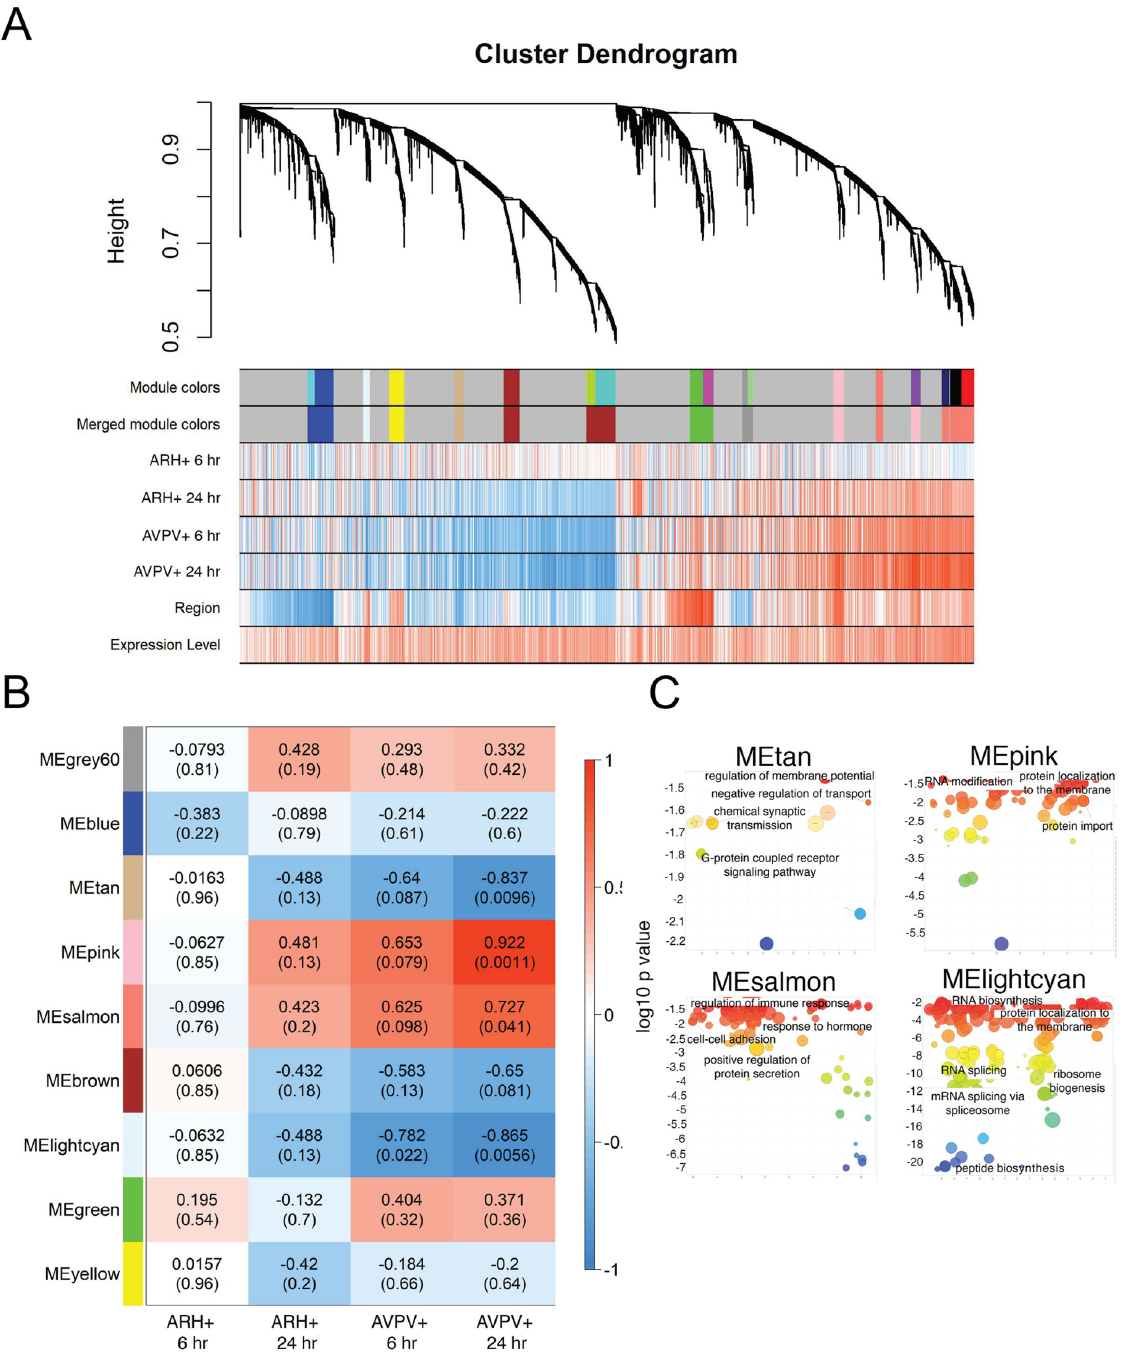
Fig 6. Gene network analysis: Clusters of genes modulated by estradiol in the combined AVPV+ and ARH+. (A) Cluster dendrogram demonstrating the hierarchical clustering of genes in the combined AVPV+ and ARH+ and heatmaps depicting the relative up- (red) and down-regulation (blue) of these modules by estradiol at 6 and 24 hrs post-EB, compared to oil baseline. (B) Heatmap showing Pearson correlation between gene coexpression modules defined by WGCNA in the combined AVPV+ and ARH+ dataset and experimental conditions (6 hrs post-EB (compared to oil baseline), 24 hrs post-EB (compared to oil baseline) and 6 vs. 24 hrs post-EB). P values are indicated in parentheses. (C) GO-terms were visualized by log10 p-value (Y-axes) and Resnik (normalized) semantic similarity of GO-terms